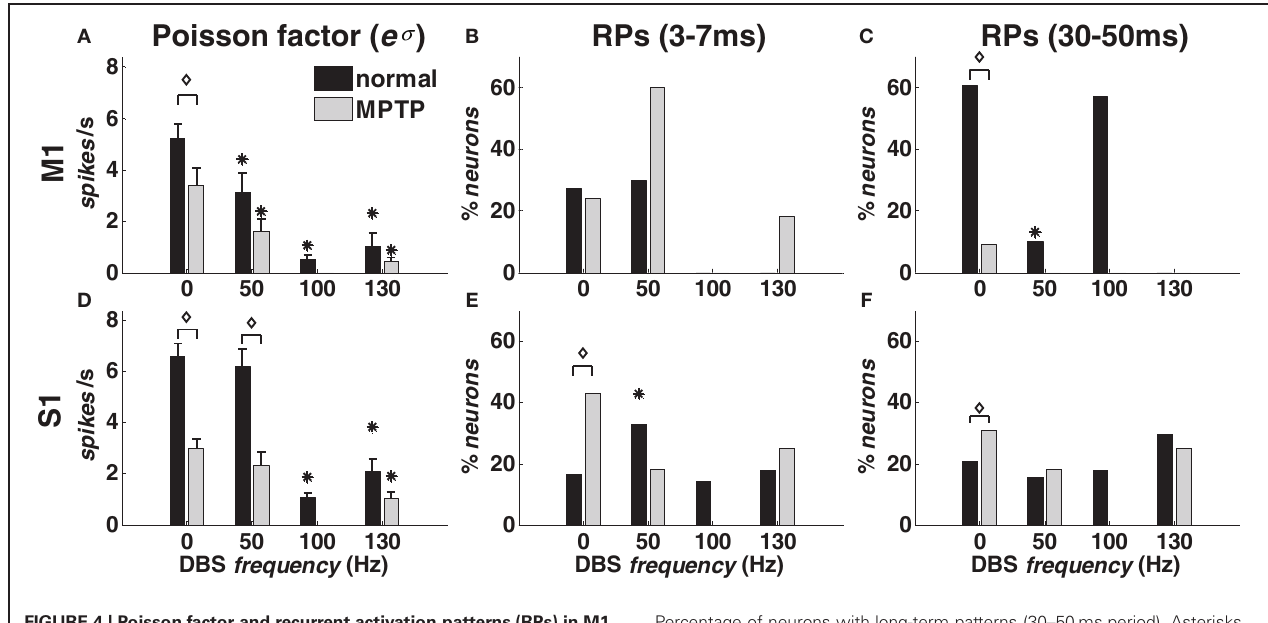
FIGURE 4 | Poisson factor and recurrent activation patterns (RPs) in M1 (A–C) and S1 (D–F) cortex in normal (black bars) and MPTP (grey bars) conditions (animal A), both at rest (0Hz) and under DBS (50, 100, 130Hz). (A,D) Population-mean value of the Poisson factor e σ (mean ± S.E.M.). (B,E) Percentage of neurons with RFPs (3–7ms period). (C,F)